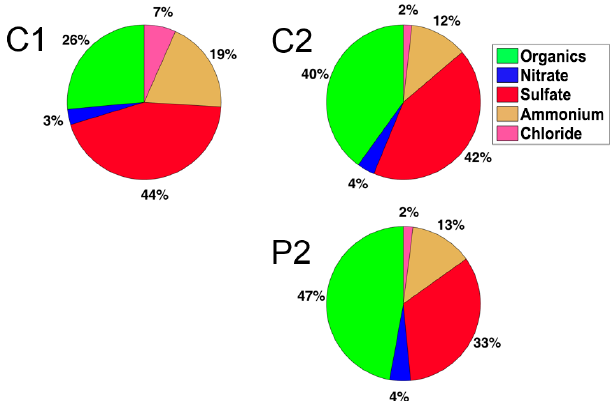
Figure 8. The average mass fraction of NR-PM 1 composition dur- ing the C1, C2, and P2